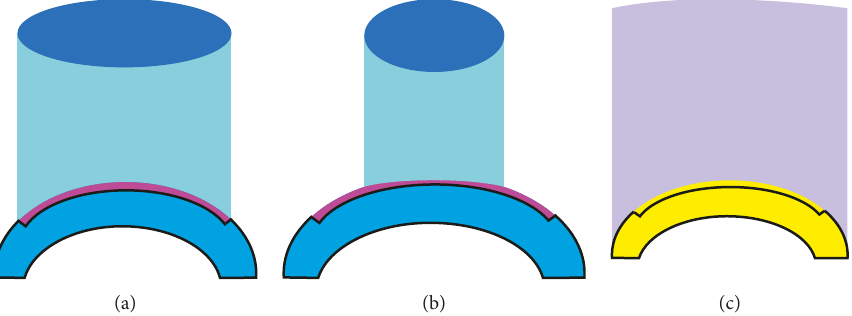
Figure 1: Schematic representation of phototherapeutic keratectomy (PTK) combined with photorefractive keratectomy (PRK) and ri- boflavin with ultraviolet-A collagen cross-linking (CXL) performed sequentially on the same day in the management of corneal ectasia after LASIK. (a) Removal of the epithelium in the previous corneal flap (PTK). (b) Tissue ablation in the previous corneal flap (PRK). (c) Riboflavin with ultraviolet-A collagen cross-linking